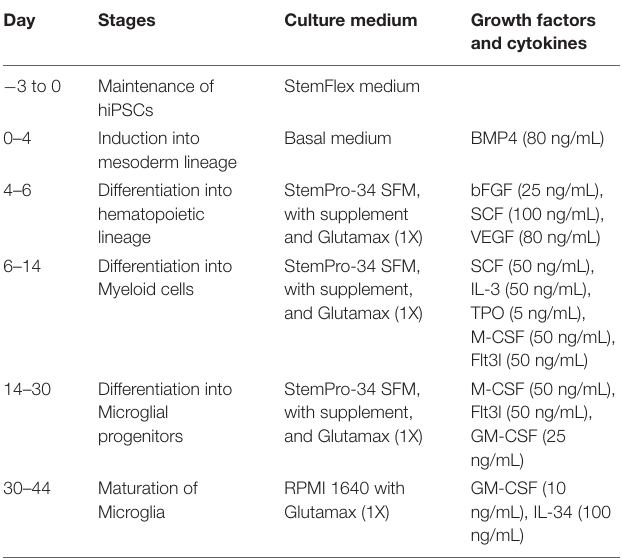
TABLE 1 | Media, growth factors and cytokines employed for iMicroglia differentiation from